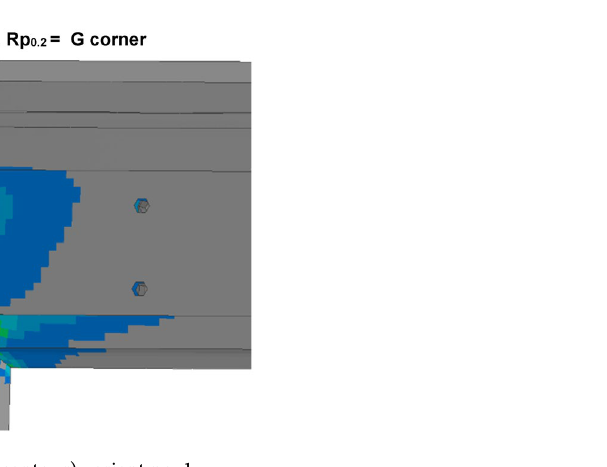
Figure 8. FEM stress map (colour contour) variant no.